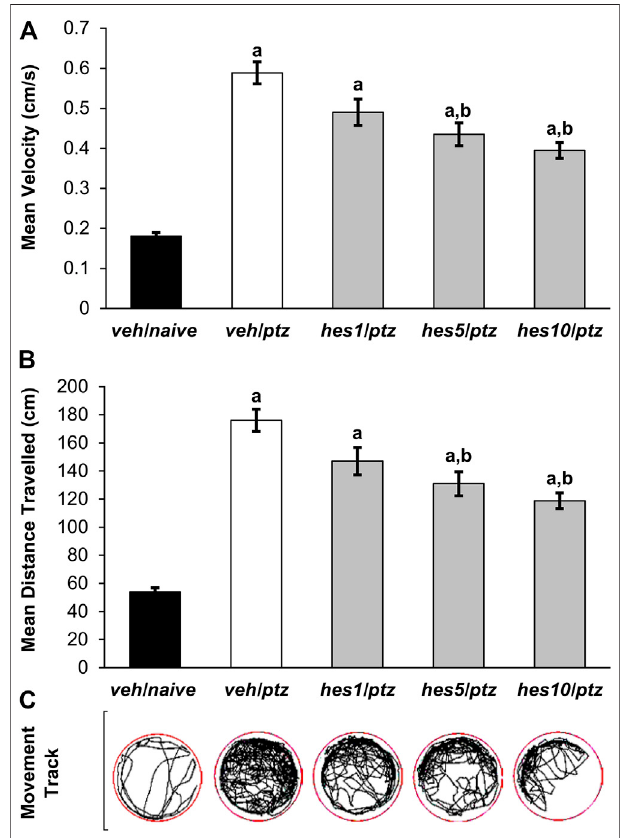
FIGURE 3 | Effect of hesperidin on PTZ-induced hyperactivity in 7 dpf zebra fi sh larvae. (A) Mean swimming speed, (B) total distance travelled, and (C) larva movement track. a P < 0.05 as compared to veh/naive (naïve) group and; b P < 0.05 as compared to veh/ptz (vehicle control) group. The resultsexpressedasmean ± SEM. veh/naive :systemwaterincubatedgroup not exposed to PTZ; veh/ptz : system water incubated group exposed to PTZ; hes1/ptz : Hesperidin 1 μ M incubated group exposed to PTZ; hes5/ ptz : Hesperidin 5 μ M incubated group exposed to PTZ and; hes10/ptz : Hesperidin 10 μ M incubated group exposed to PTZ.